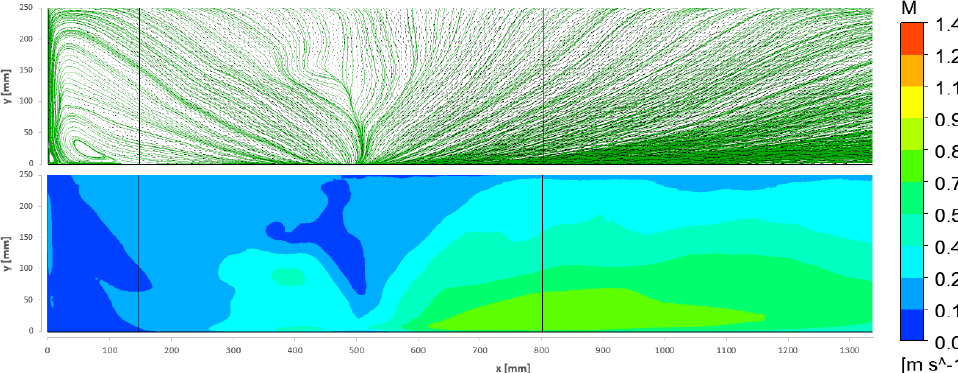
Figure 21. Finite volume method (SAS model), vector lines ( top ) and the magnitude of time-averaged 2D velocity ( bottom ) in vertical plane ( z = − 141mm )